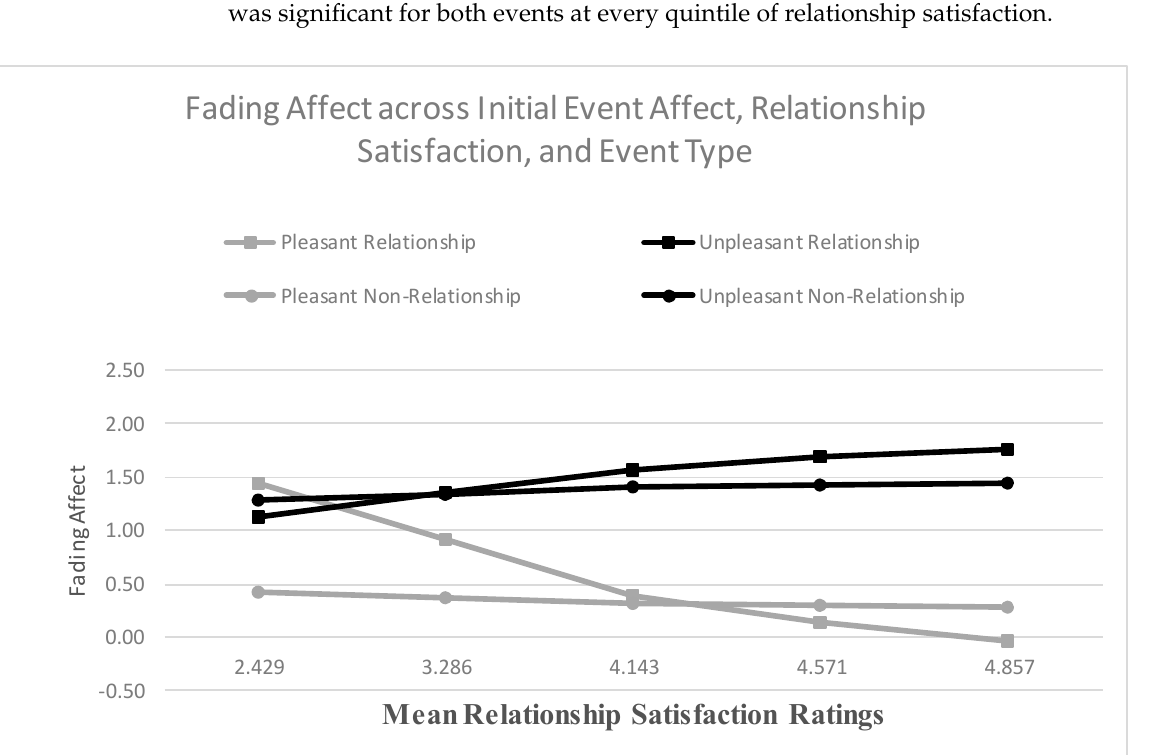
Figure 10. Fading affect for pleasant and unpleasant relationship and non-relationship events across quintile levels (10th through 90th) of relationship satisfaction. Table 3. Fading Affect Bias Regression Coefficients (SE) for Relationship Events and Non ‐ Relation ‐ ship Events across Quintiles (Mean Rating) of Relationship Satisfaction Ratings (large positive coef ‐ ficients represent large FAB).